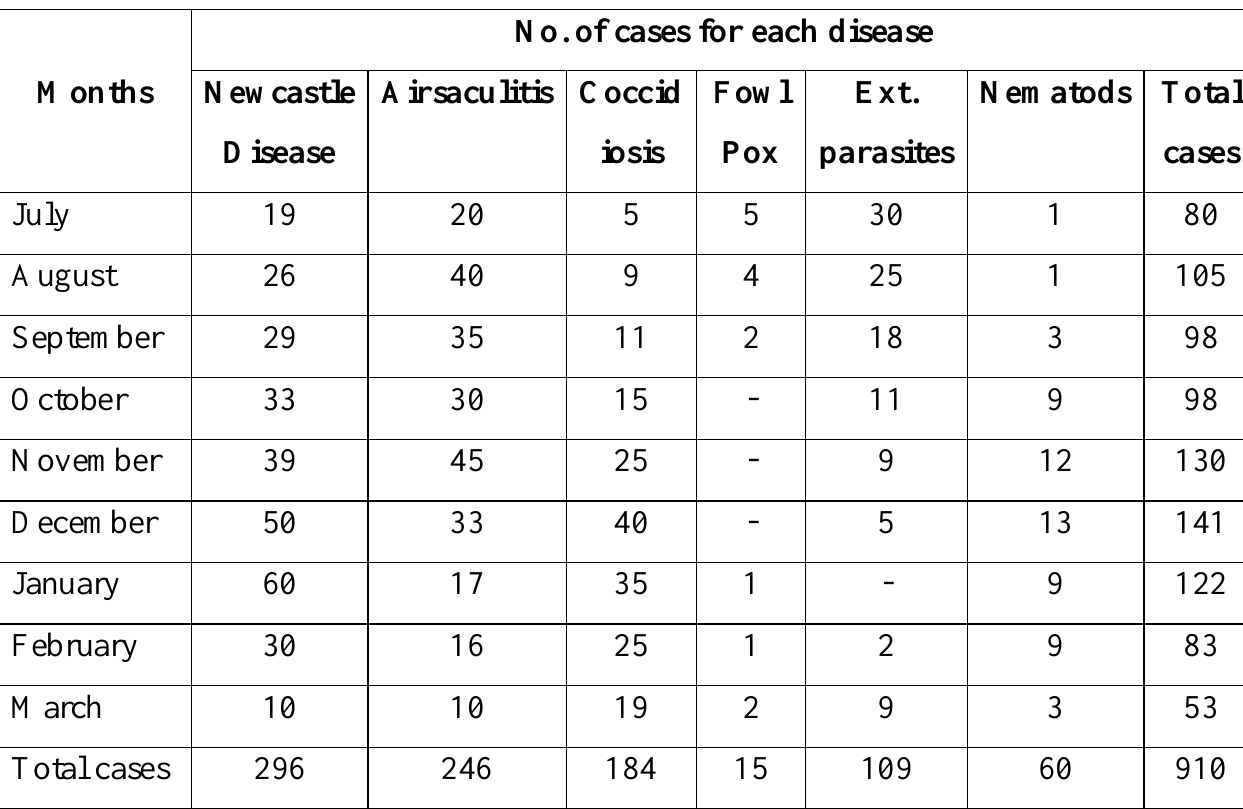
Table (2): number of cases during the study period